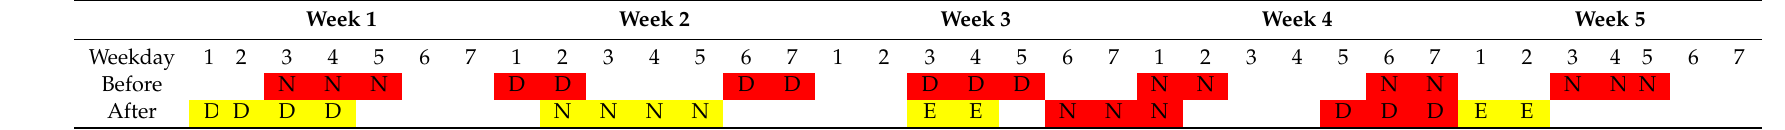
Table 2. The shift plan for Plant B during the nine months prior to plant shutdown and the standard shift plan they return to after reopening. Week